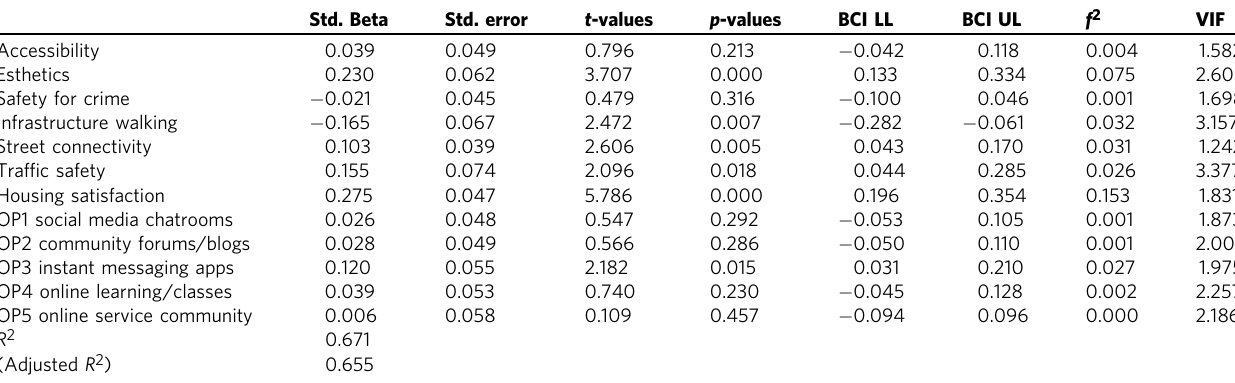
Table 3 First place, online third place and life satisfaction of the